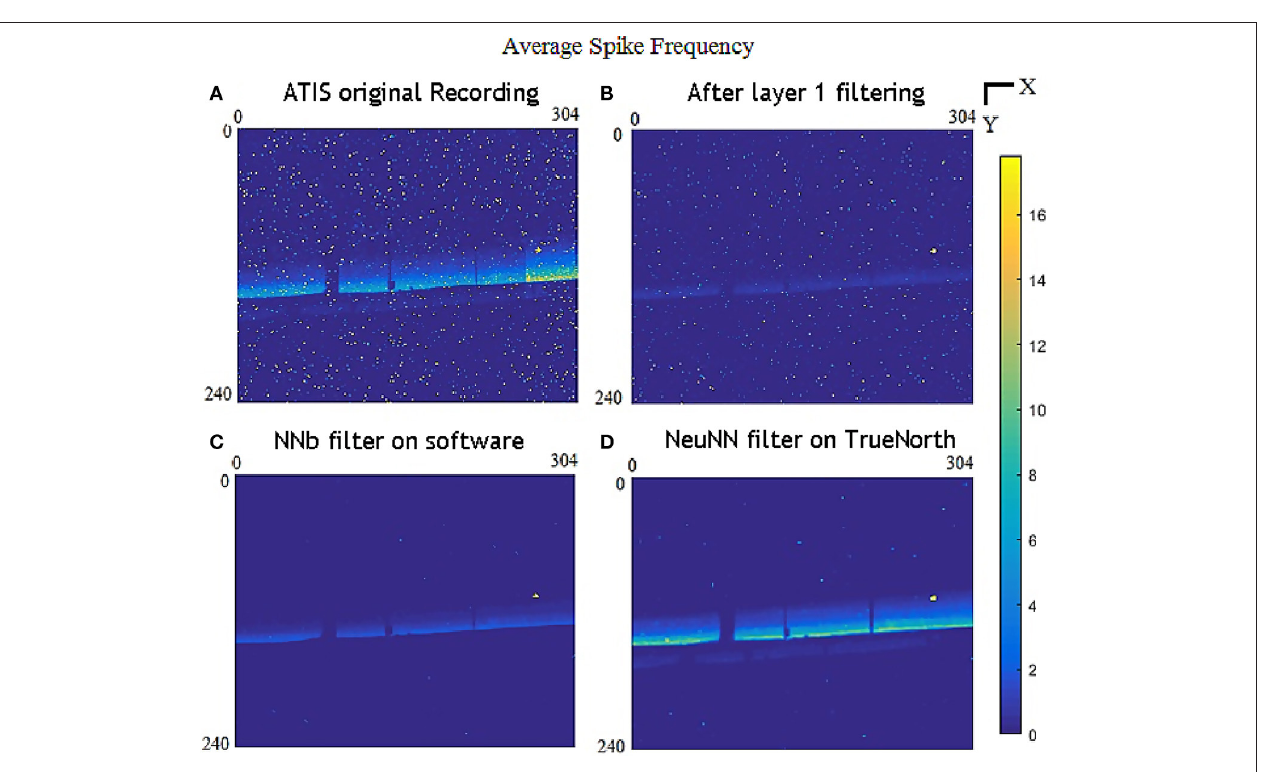
FIGURE 6 | Comparison of color-coded average spike frequency (events/s) at each pixel for all 304 after layer 1refractory period of 5 ms; (C) after layer 1 refractory filter and layer 2 NNb filter on software; and (D) after layer 1 refractory filter with layer 2 NeuNN filter on